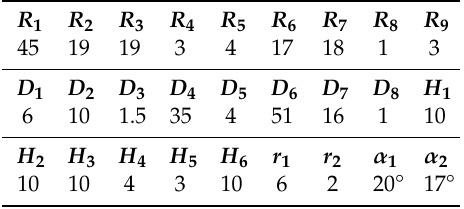
Table 3. Dimensions of the designed antenna (mm).